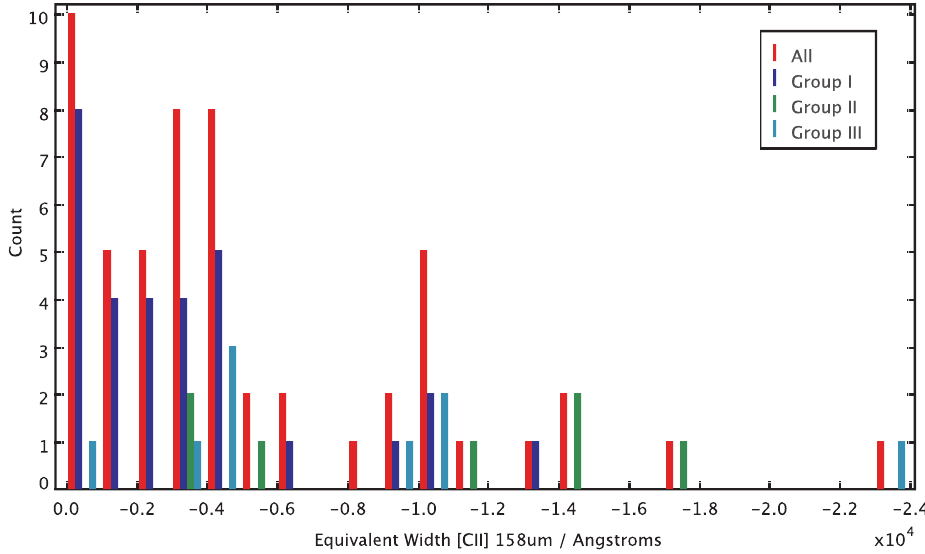
Fig. 4. Histogram of [C II] 158 (cid:22) m equivalent widths showing the SED groups: group I (blue), group II (green) and group III (cyan). The histogram for all sources is shown in red, eight sources having unclassi(cid:12)ed SEDs (no IRAS or 2MASS